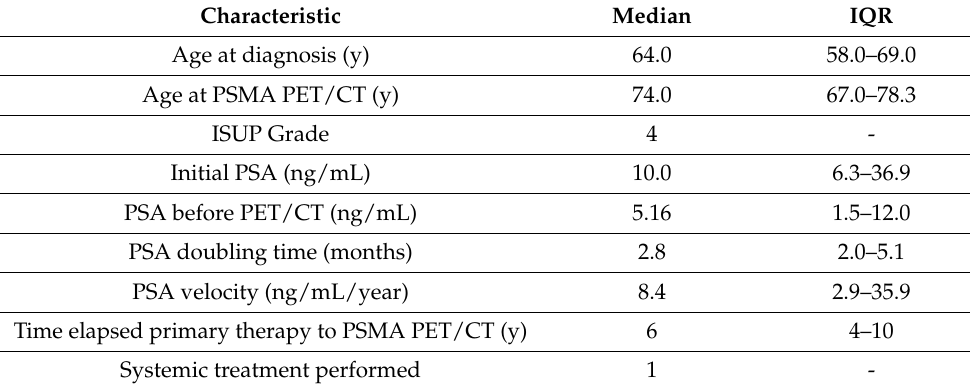
Table 1. Patient